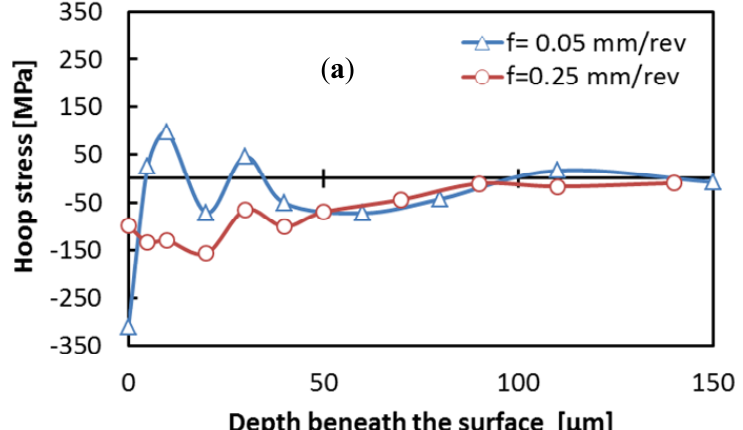
Figure 15. Effect of cutting feed on ( a ) hoop and ( b ) axial residual stress distribution for cutting speed of 300